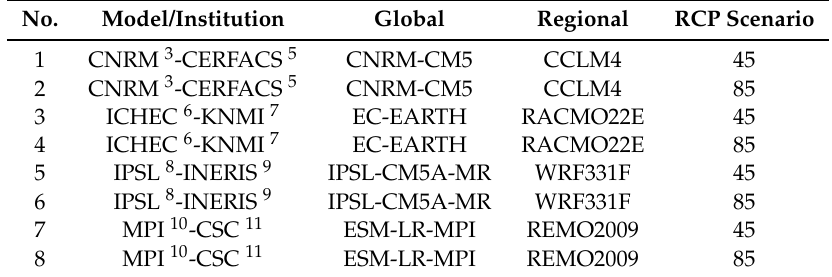
Table 2. List of EURO-CORDEX bias corrected with EOBS10 used in this work. The experiment used was the control historical simulation (r1i1p1 ensemble member at 0.11 ◦ of resolution). No. Model/Institution Global Regional RCP Scenario 1 CNRM 3 -CERFACS 5 CNRM-CM5 CCLM4 45 2 CNRM 3 -CERFACS 5 CNRM-CM5 CCLM4 85 3 ICHEC 6 -KNMI 7 EC-EARTH RACMO22E 45 4 ICHEC 6 -KNMI 7 EC-EARTH RACMO22E 85 IPSL 8 -INERIS 9 IPSL-CM5A-MR IPSL 8 -INERIS 9 IPSL-CM5A-MR WRF331F 85 MPI 10 -CSC 11 ESM-LR-MPI REMO2009 45 MPI 10 -CSC 11 ESM-LR-MPI REMO2009